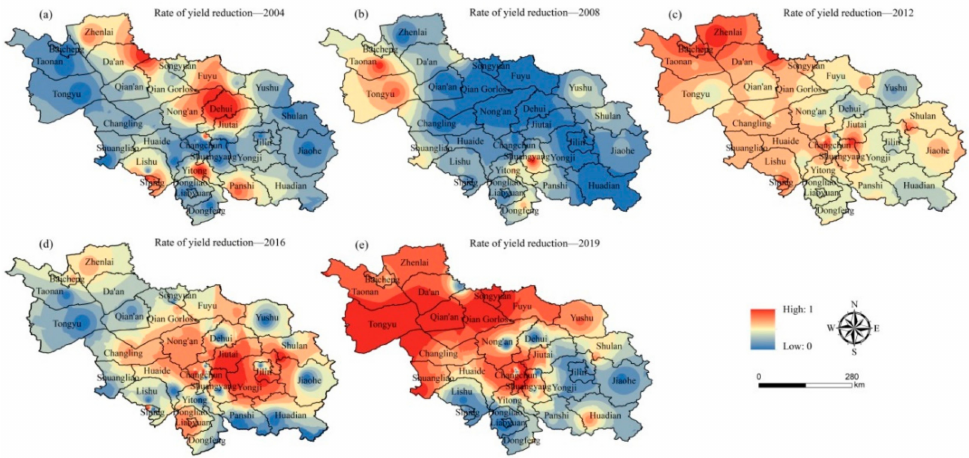
Figure 10. Spatial distribution of maize yield reduction